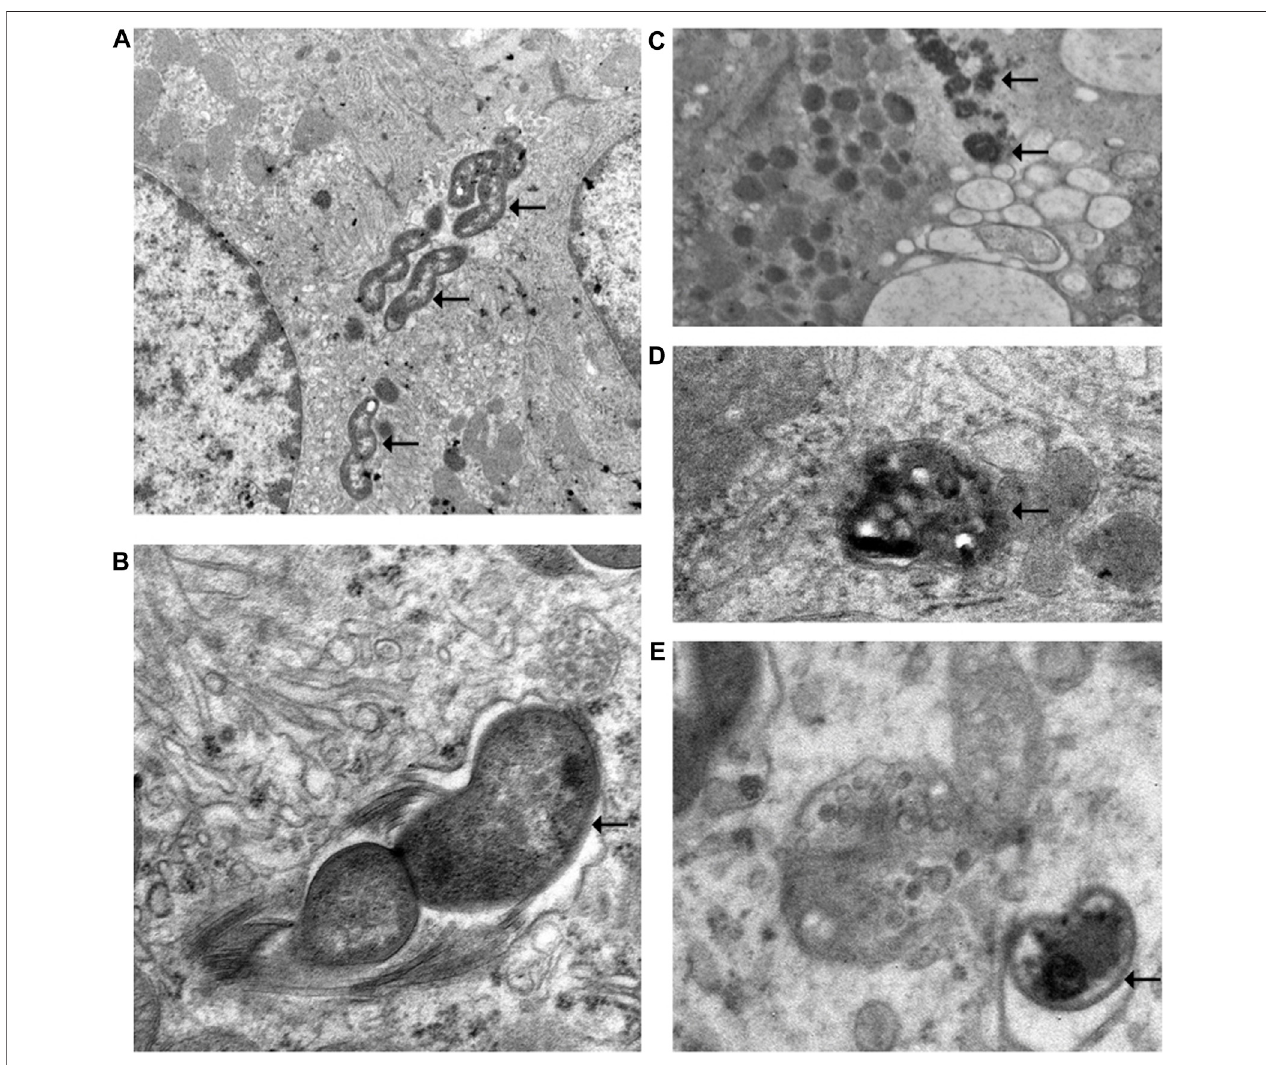
FIGURE 9 | Electron microscopic observation of NHPH in infection-alone and infection + vonoprazan-treated mouse gastric parietal cells. (A) In infection alone mouse, many NHPHs were seen within the intracellular canaliculus of the parietal cell in the gastric mucosa, X 8,000. (B) In a higher magni fi cation, fl agella were recognized adjacent to the NHPH cell body in the intracellular canaliculus, X 24,000. (C) In the infection + vonoprazan-treated mouse, the bacterial cell body became condensedandirregular (arrows)intheintracellularcanaliculusoftheparietalcell, X8,000. (D,E) Manybacilliwerefoundinthesecondary lysosomeintheinfection + vonoprazan-treated group, X